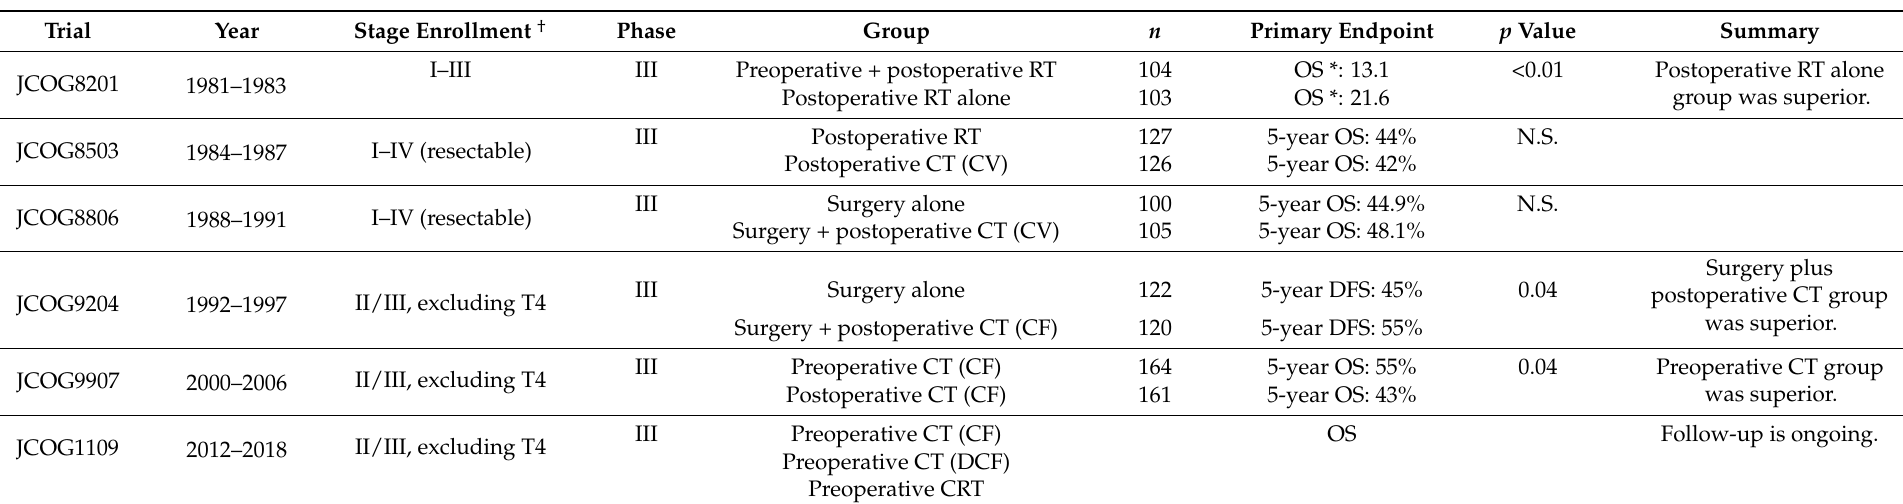
Table 1. Overview of clinical trials of adjuvant therapy for ESCC in